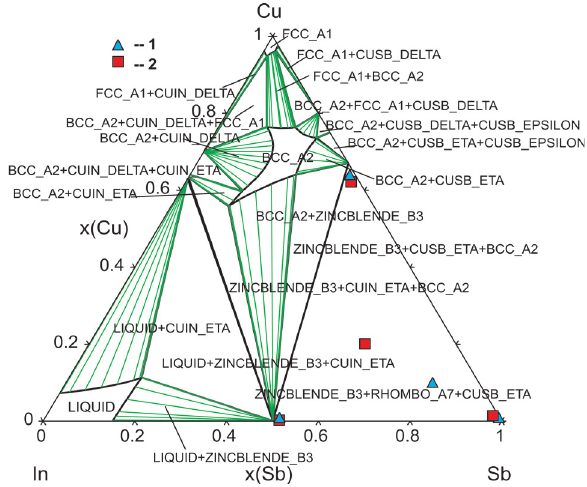
Figure 9. Isothermal section of ternary Cu-In-Sb system at 673